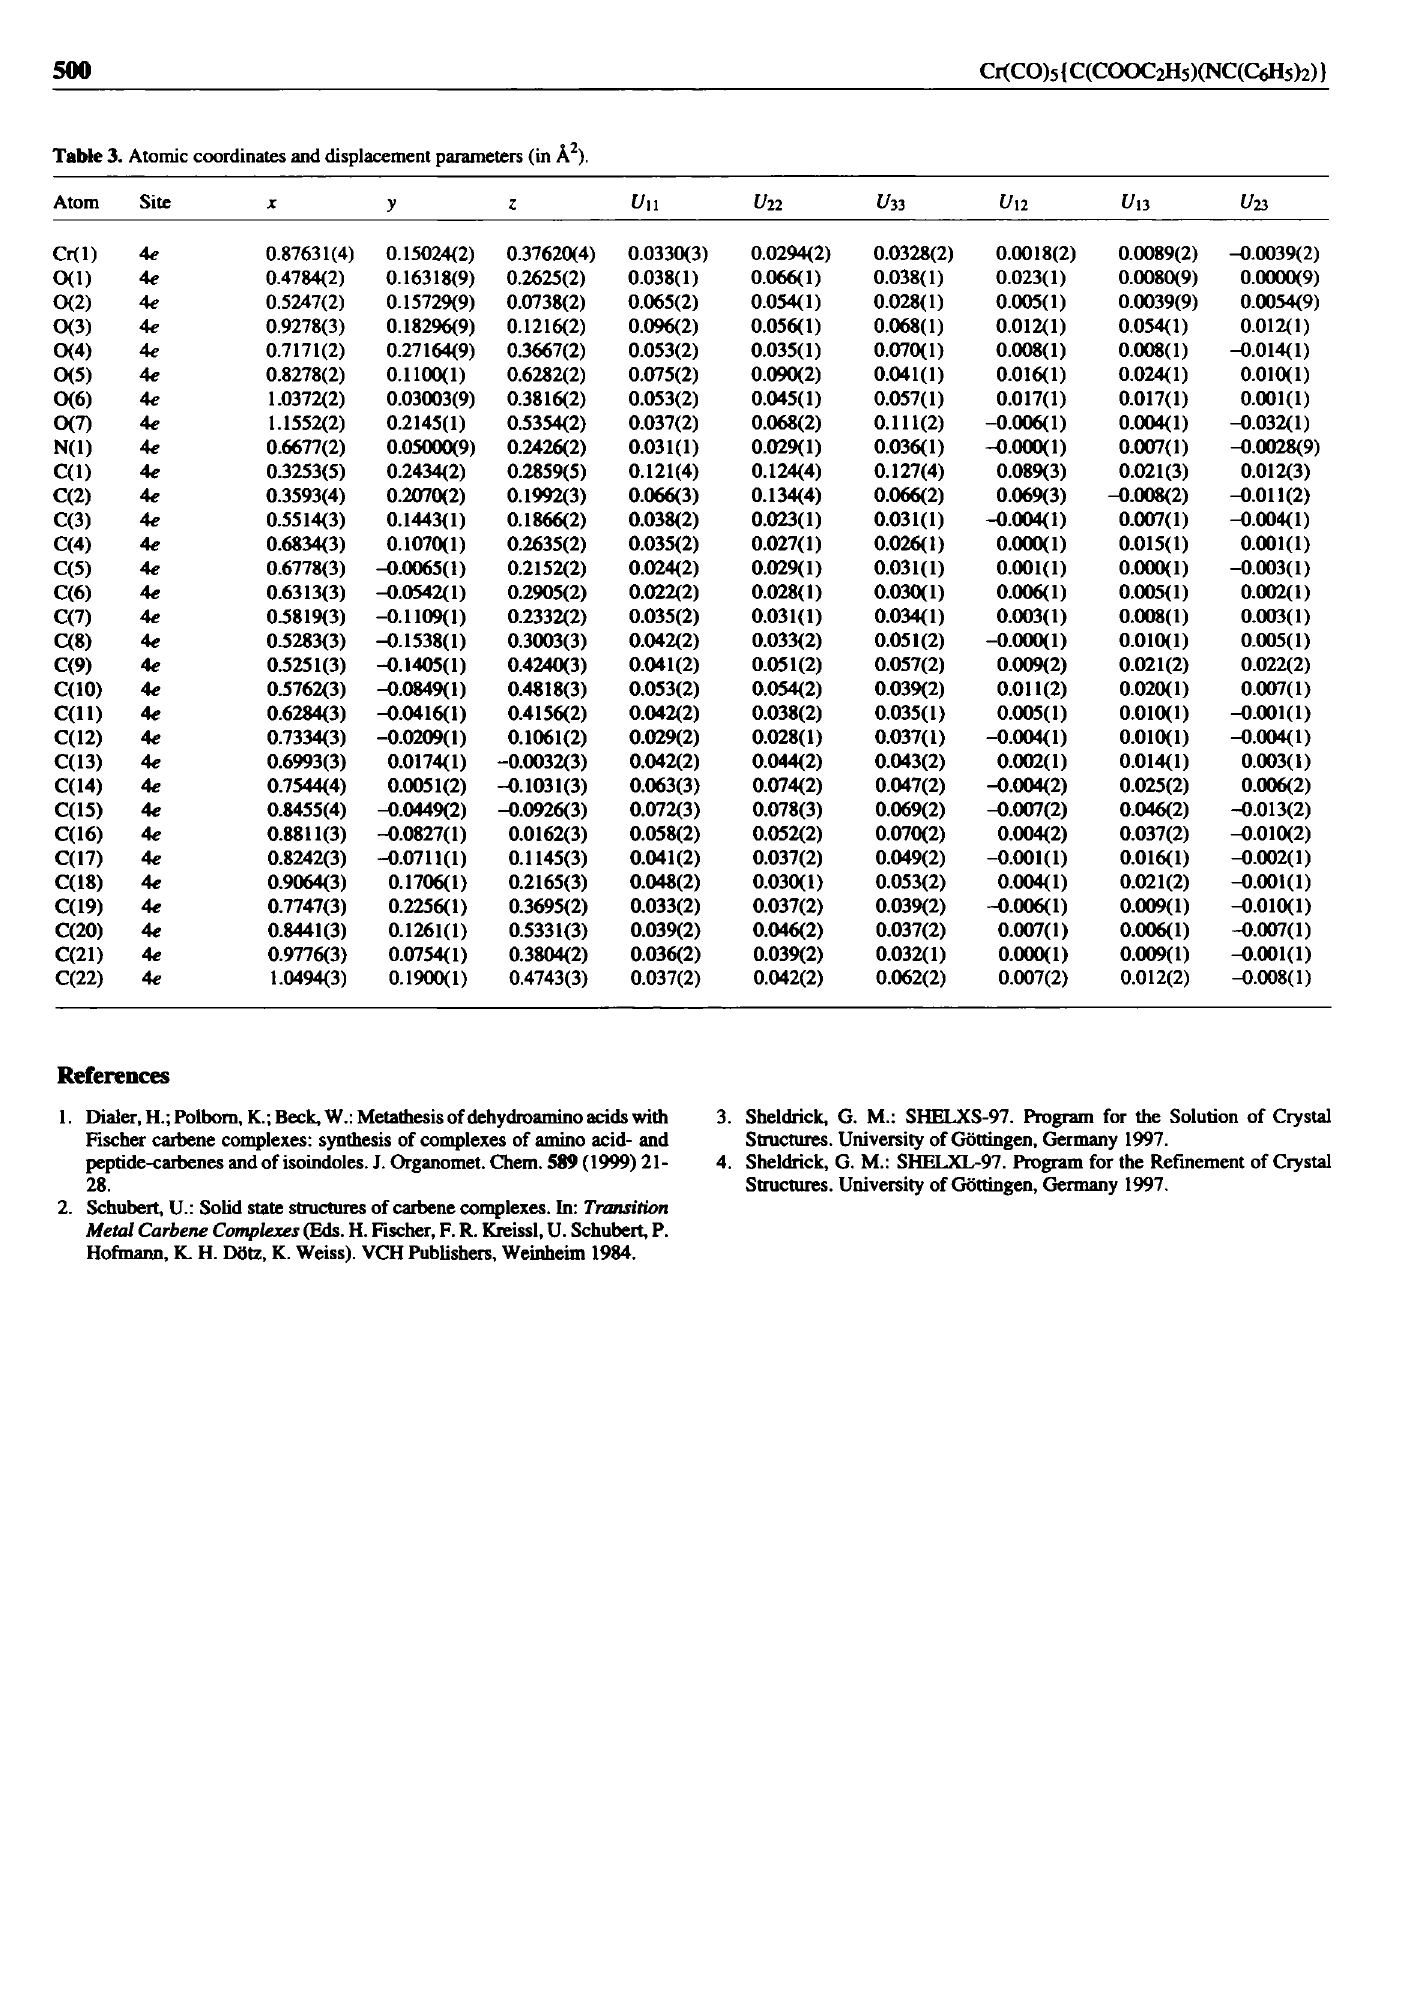
Table 3. Atomic coordinates and displacement parameters (in A 2